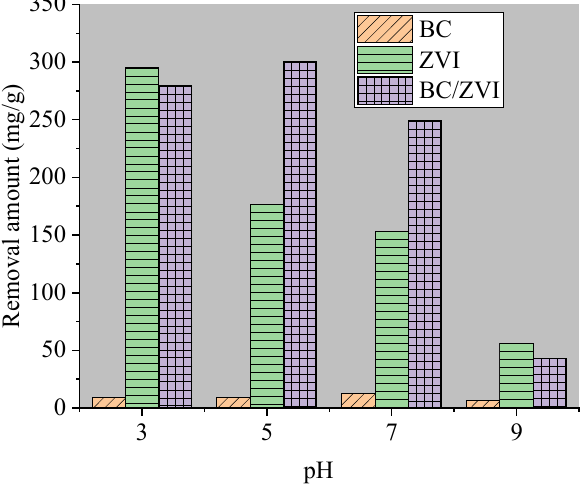
Figure 6. Adsorption effect of BC material on TC at different pH values.